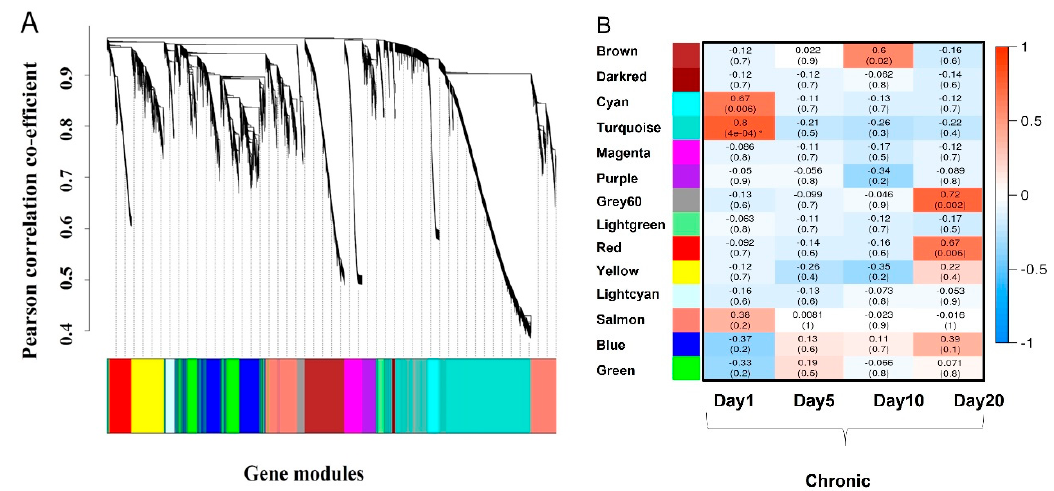
Figure 1. Dendrogram of all genes identified by RNASeq by hierarchical clustering. ( A ) The genes identified in the RNASeq were clustered into modules using WGCNA. The modules were named after different colors which are plotted on the X -axis. Hierarchical clustering was used for clustering the genes into modules according to correlation. The height of the gene tree plotted on Y -axis is a measure of the Pearson correlation co-efficient. ( B ) The module trait heatmap plots the timepoint (days) after wounding on the X -axis and the module eigengene. Eigengenes are pseudogenes representative of the expression value of genes included in the respective module of the identified modules from RNASeq on the Y -axis. The value in the boxes is the Pearson correlation co-efficient of the module eigengene to the respective timepoint on the X -axis and the value in the bracket is the statistical significance ( p -value) for the correlation. Note: * the p-value of the turquoise module on Day1 is 0.0004.